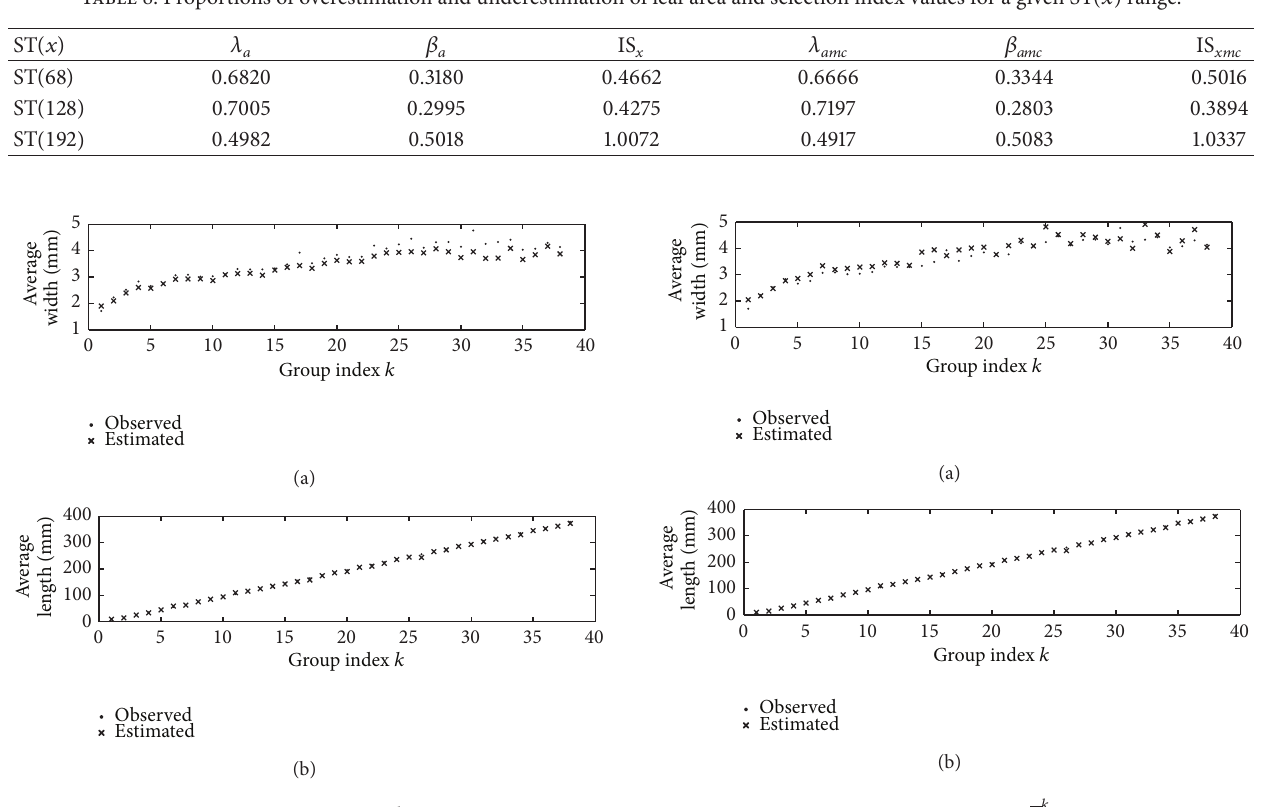
Figure 3: (a) Comparison of observed ℎ ℎ 𝑘 𝑑 width averages taken over groups 𝑘 observed 𝑙 𝑜 and image estimated groups 𝐺 𝑘 (𝑙) (see Table 6). The values obtained from digitized leaves were estimated by using ST (68) . The values obtained from digitized leaves were estimated by using ST (192)